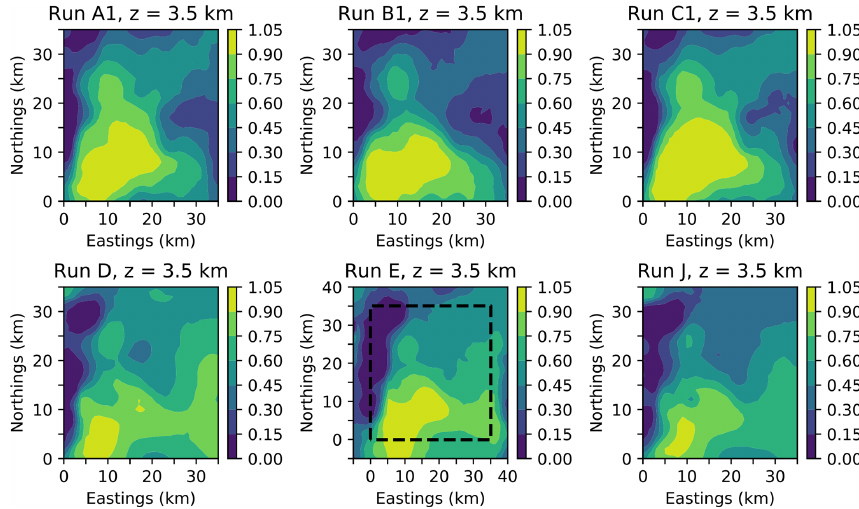
Figure 4. Slices through the voxelized posterior probability of occupancy by granite for each run at a depth of 3.5km.